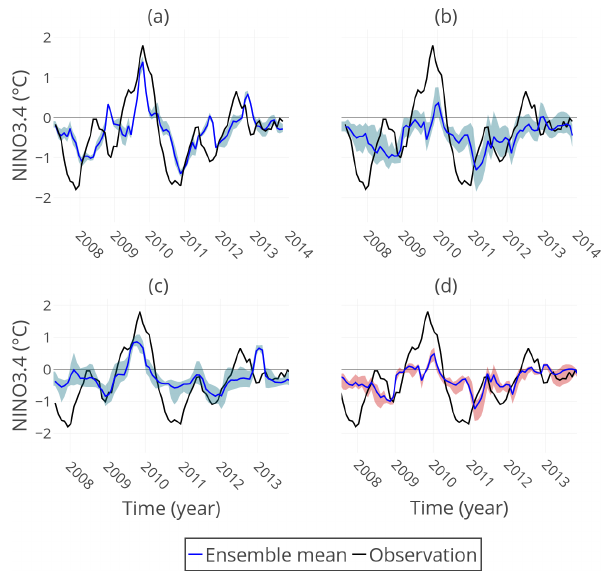
Figure 8. Spread and mean (blue line) of ensembles of hybrid model predictions with different hyperparameter values. The nine optimal (in terms of NRMSE) predictions from the 84 different ANN structures at the (a) 4-month lead time, (b) 6-month lead time and (c) 12-month lead time. (d) Ensemble with 9 ≤ p ≤ 14 in the ARIMA order with their optimal ANN structure at 6-month lead time prediction (at the 4- and 12-month lead there is almost no spread). Black is the observed NINO3.4 index.